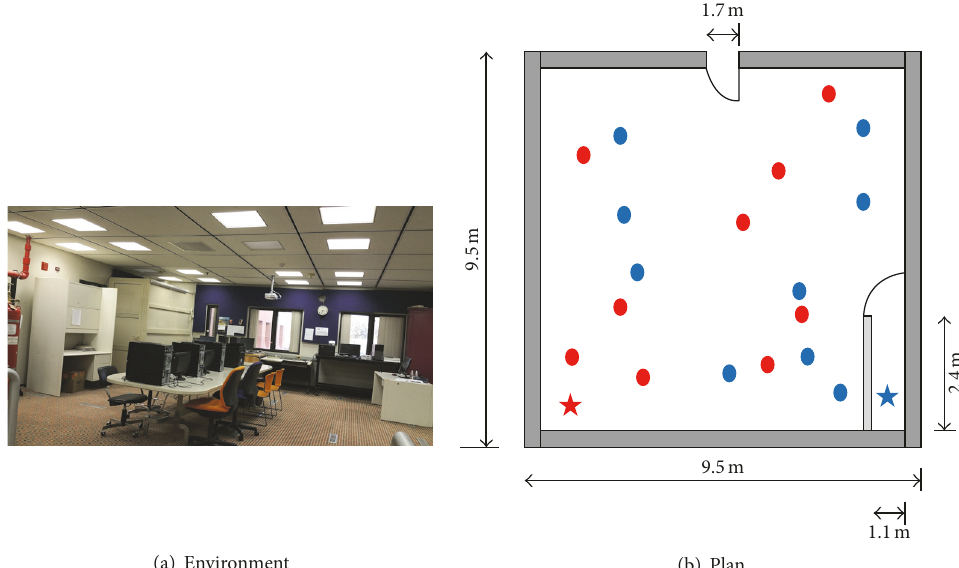
Figure 1: The indoor lab in which the LOS (red points) and the NLOS (blue points) receiver spatial diversity power measurements have been conducted. The stars represent TX locations while the circles represent RX locations: (a) the actual environment and (b) the plan.